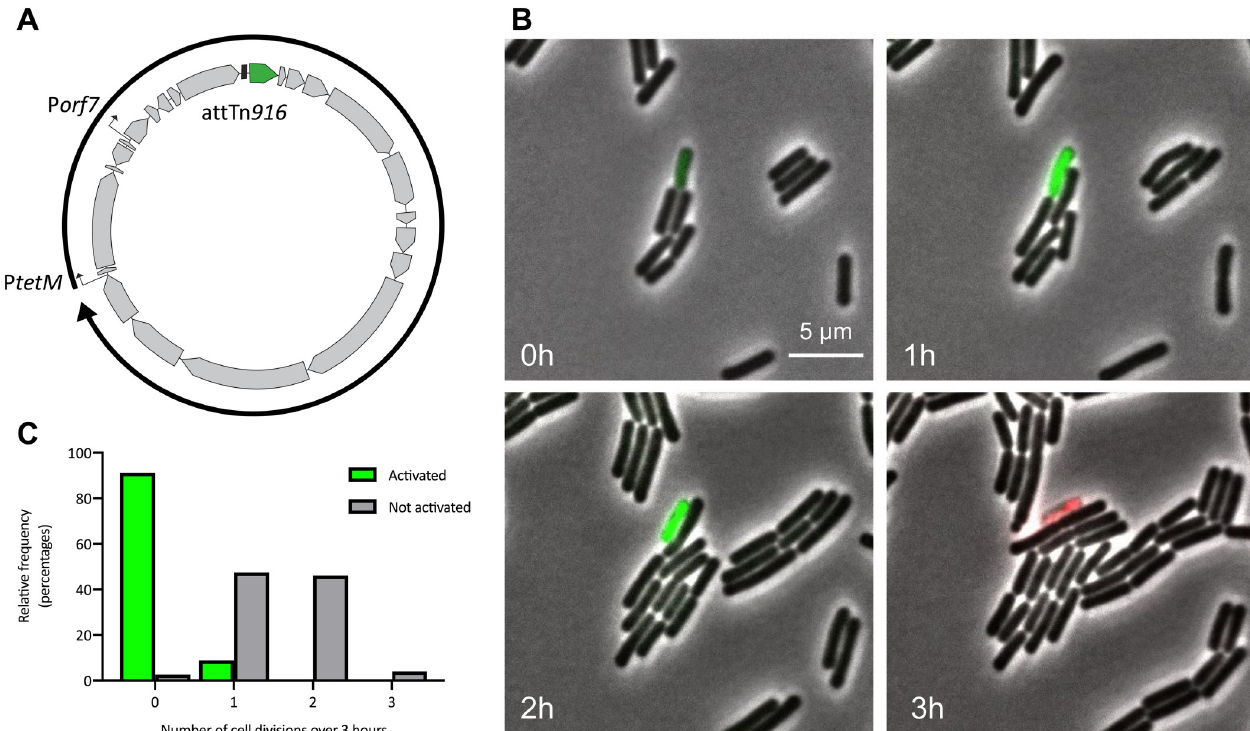
Fig 6. Tn 916 -activated B . subtilis cells exhibit growth defects. A) The fluorescent reporter system for monitoring Tn 916 excision (Tn 916 - gfp ).A circular genetic map of Tn 916 is shown, with gray boxes with arrows indicating Tn 916 open reading frames, bent arrows representing promoters, and a black box representing the circular attachment site, att Tn 916 . P tetM and P orf7 are predicted to drive expression of orf24 - orf13 following excision and circularization of the element (reviewed in [4]). gfpmut2 (shown in green) was inserted upstream of orf24 such that it is expressed following element excision. B,C) Cells containing Tn 916 - gfp integrated between yufK - yufL (ELC1458) were grown in minimal glucose medium to late exponential phase with 2.5 μ g/ml tetracycline to stimulate Tn 916 excision. At time = 0 h, cells were spotted on minimal glucose agarose pads containing 2.5 μ g/ml tetracycline, 0.1 μ M propidium iodide, and 0.035 μ g/ml DAPI. Cells were monitored by phase contrast and fluorescence microscopy for three hours. B) A representative set of images from these experiments. GFP (green) was produced in cells in which Tn 916 was activated and excised from the chromosome. Propidium iodide (red) indicates dead cells. C) Histogram displaying the relative frequency (percentage) of Tn 916 - gfp activated cells that underwent the indicated number of cell divisions, compared to non-activated (GFP-negative) cells. DAPI and phase contrast were used for monitoring cell division